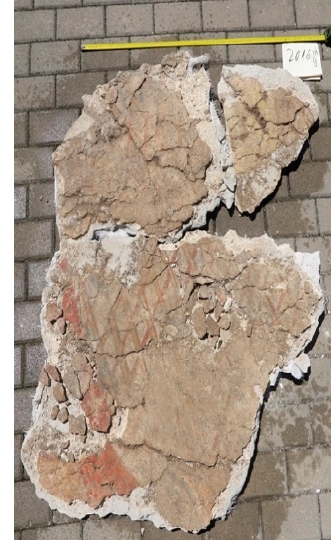
Figure 1. Photos of the Rapoltu Mare fresco.